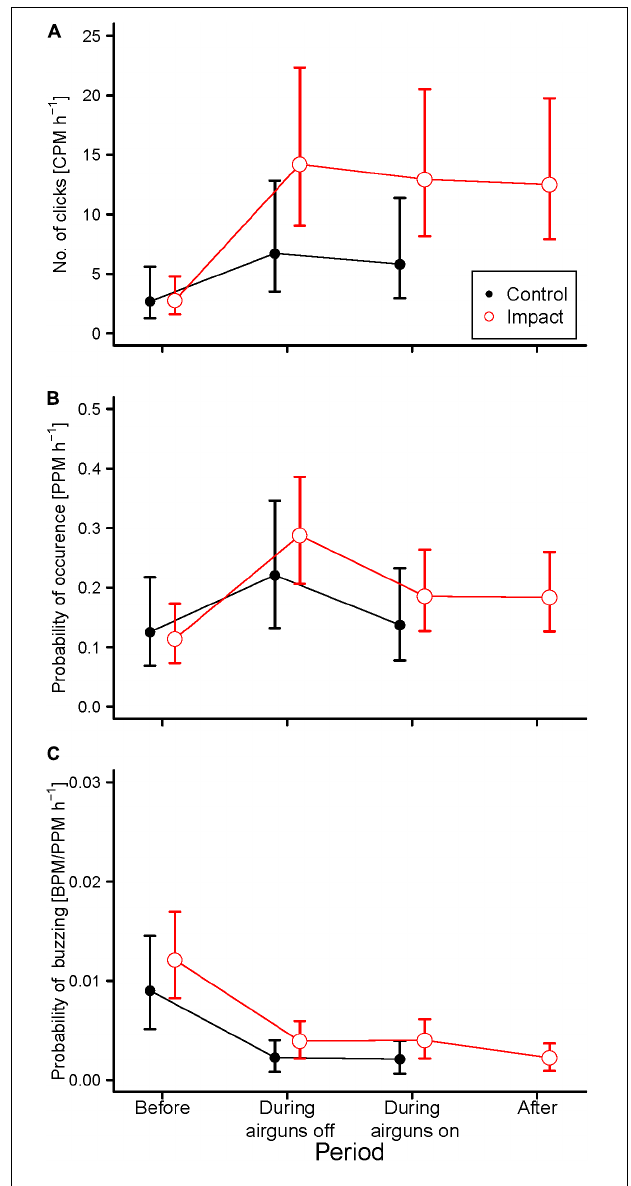
FIGURE 5 | Predicted (circles: mean and whiskers: 95% CI) porpoise activity at the “control” and “impact” stations, before, during (with airguns off or on) and after the seismic survey, expressed as, (A) the number of porpoise clicks (CPM h − 1 ), (B) probability of occurrence (PPM h − 1 ), (C) probability of buzzing (BPM/PPM h − 1 ). Each panel is the result of a separate generalized mixed model (see text for details) ( Supplementary table S7 ). Each model included Julian day and hour of the day as covariates to accommodate variation in seasonal and diurnal activity of